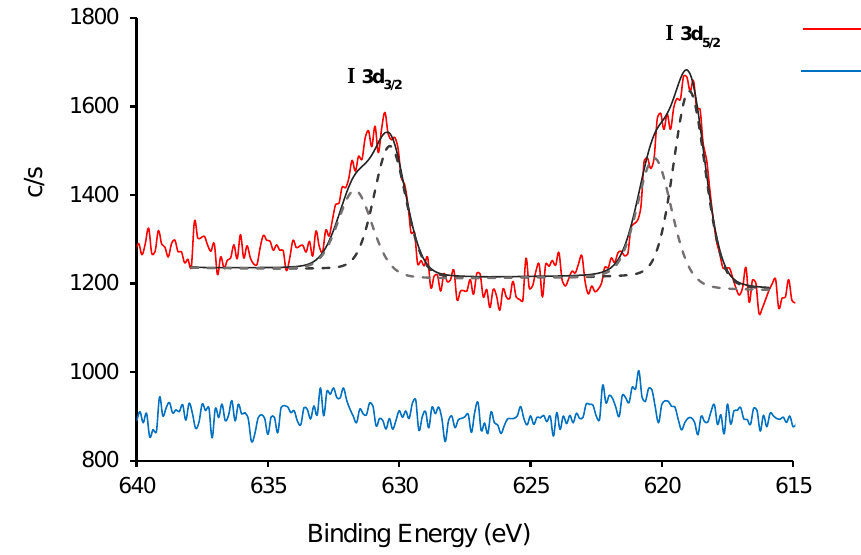
Figure 5. Iodine region of XPS spectra for HP- β -CD/I 2 and HP- β -CD